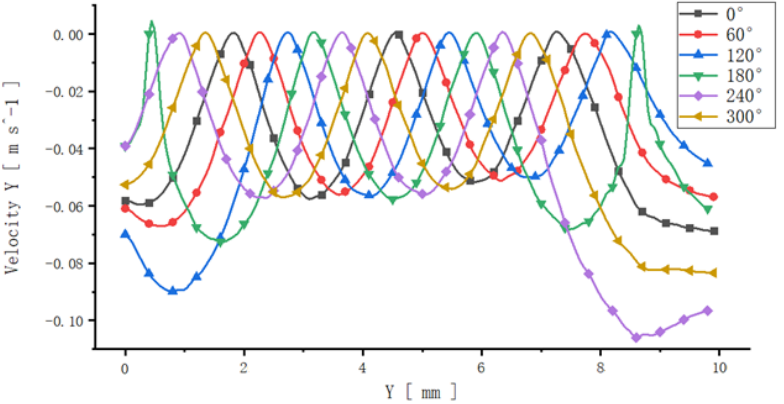
Figure 10. Velocity curves on the wall along the 6 angle directions.